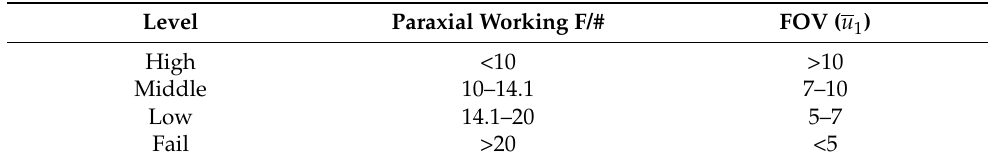
Figure 3. The optimization results with the optical parameters ( l 1 , l 2 (cid:48) , l 1 , l (cid:48) 2 , and M) = ( − 2.704 mm, 1.9055 mm, − 1.643 mm, 105.436 mm, and − 3.463) based on rule 2. Table 2. The specification